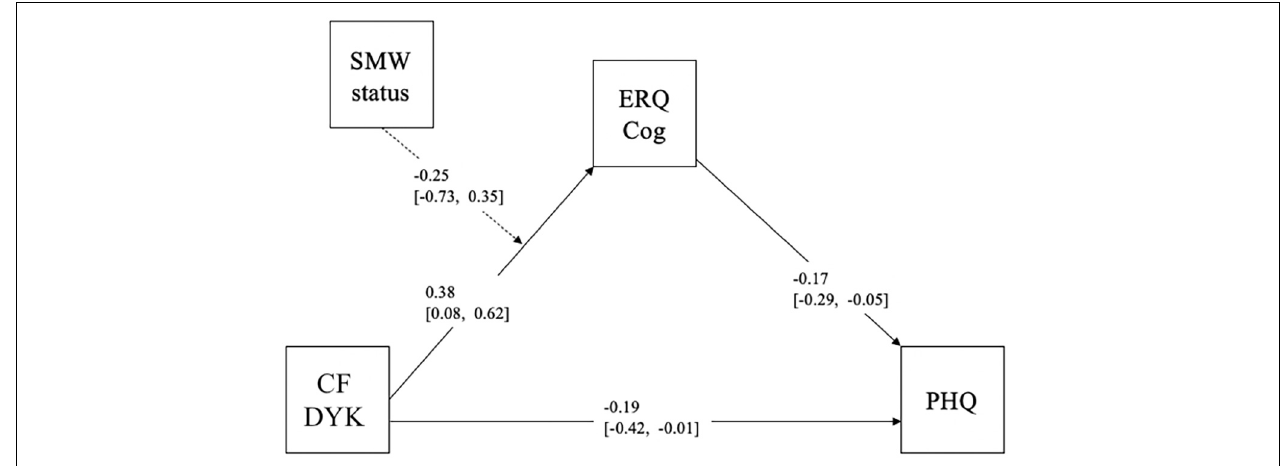
FIGURE 1 | Overall model full sample. SMW, Sexual Minority Women Status; CF DYK, Chosen Family Do You Know; ERQ Cog, Emotion Regulation Questionnaire-Cognitive Reappraisals; PHQ, Patient Health Questionnaire-9.